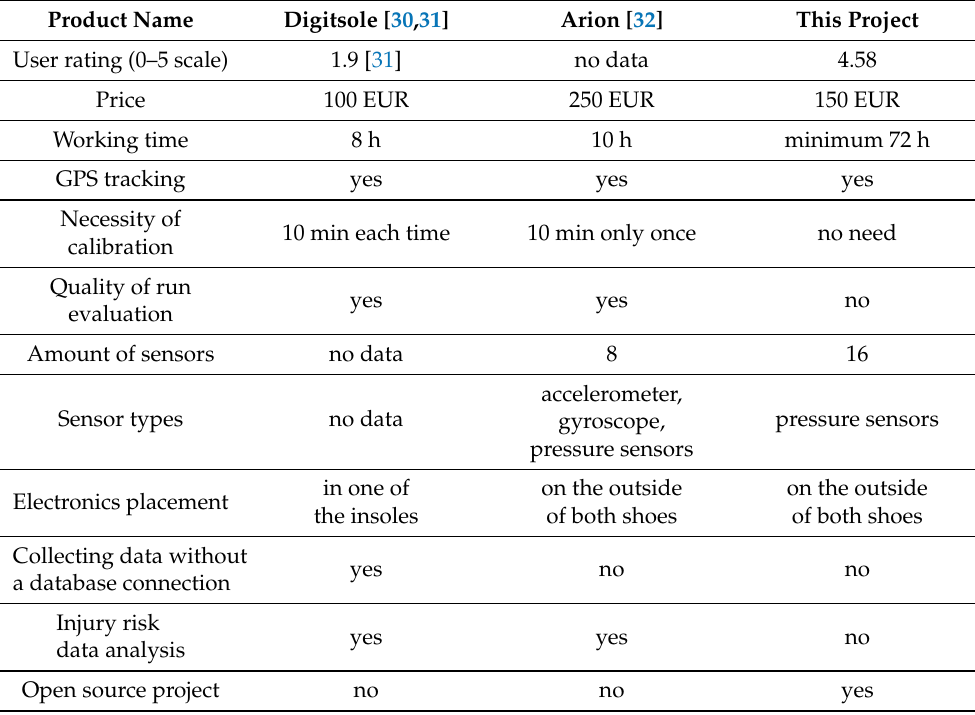
Table 5. Comparison of the effects of work with commercial